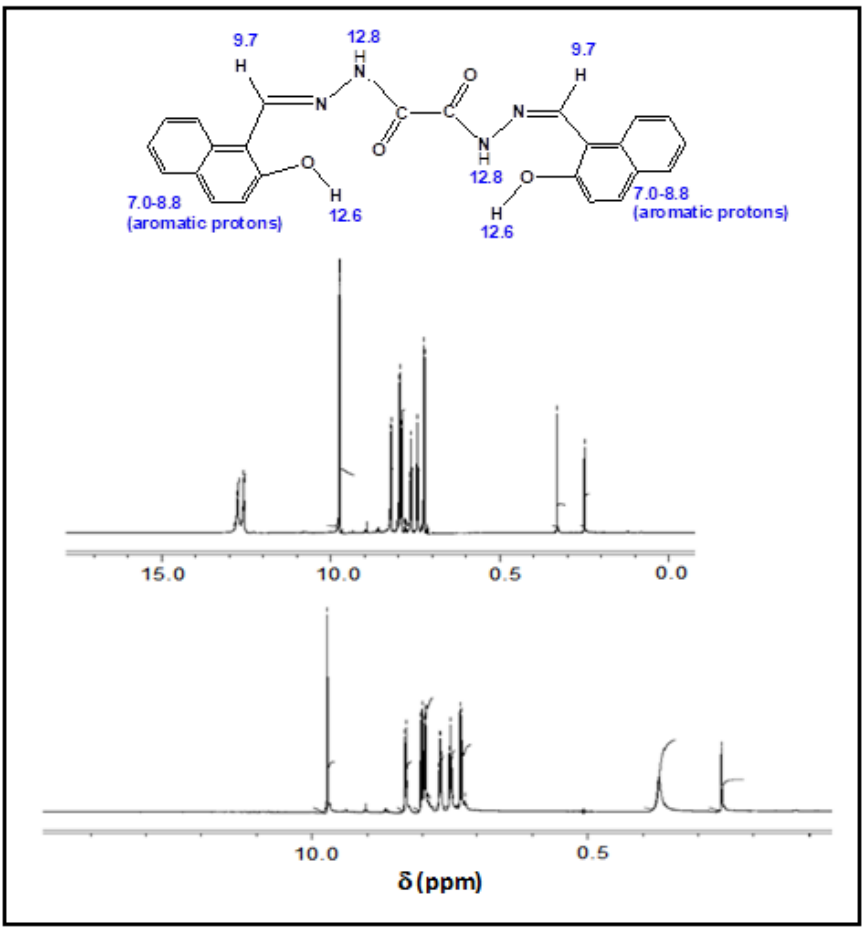
Figure 4. 1 H NMR spectrum of HAO in DMSO- d 6 at RT.